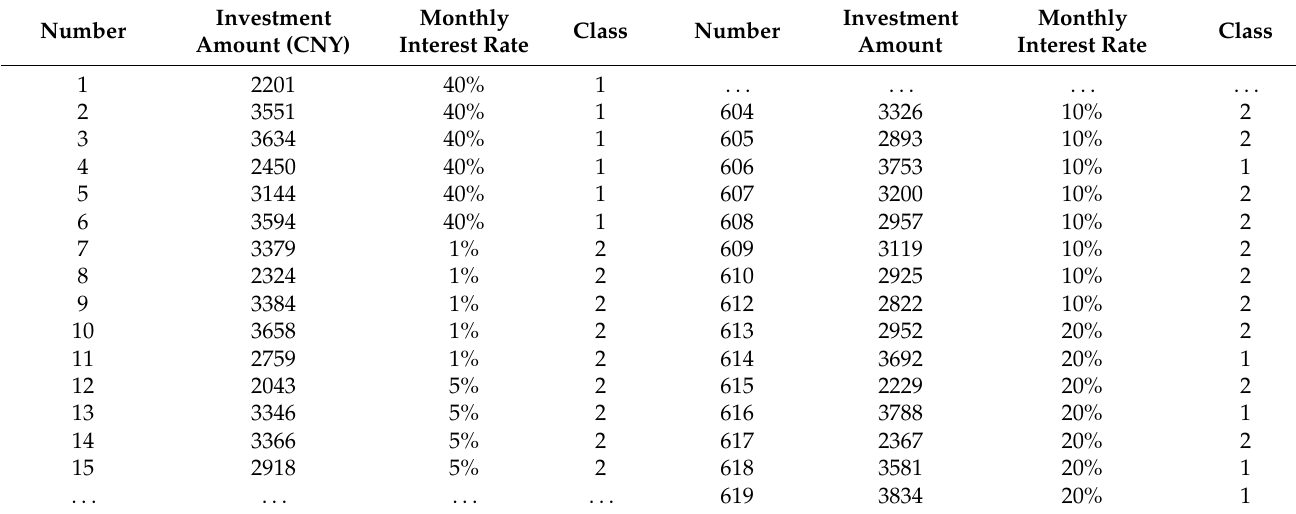
Table A4. Training set data.